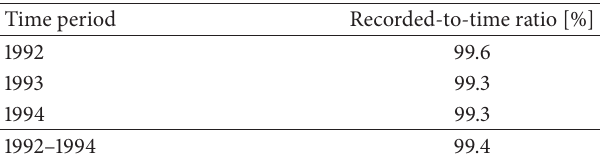
Table 1: Recorded-to-total time ratio in percent on a yearly basis for the period 1992 to 1994 in Kuala